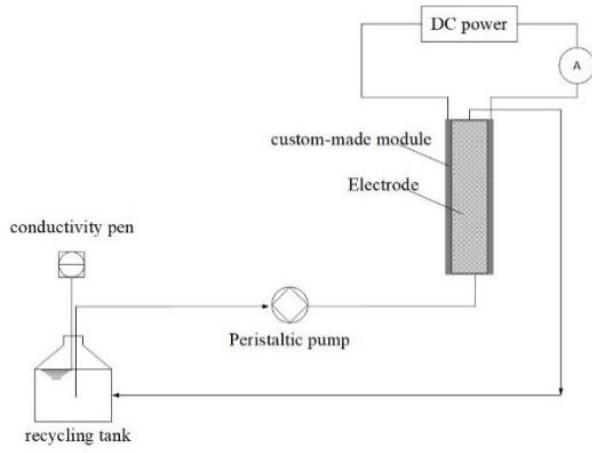
Figure 5. Schematic diagram of the electrosorption experiments.